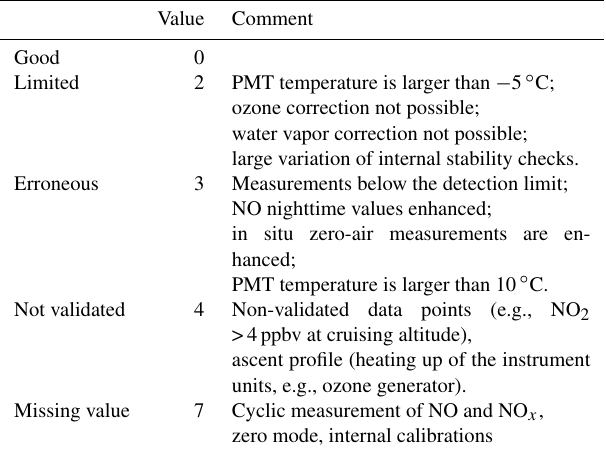
Table 5. Criteria for flagging the NO x data according to QA/QC definition in IGAS